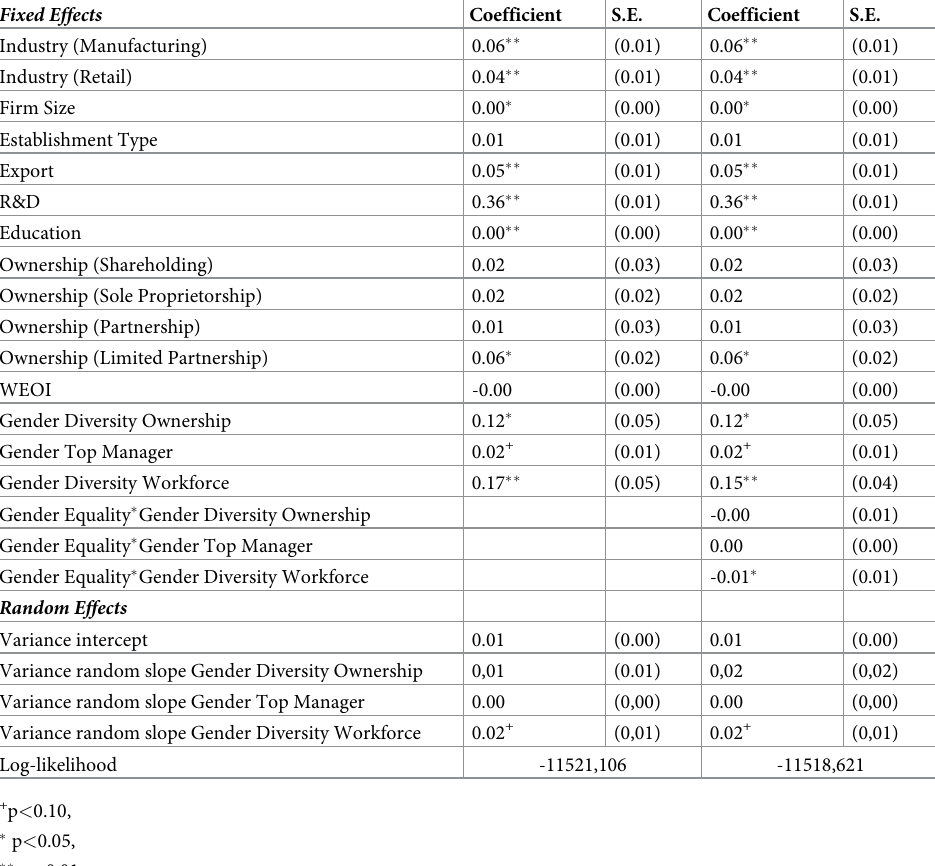
Table 4. Robustness test. Hierarchical linear model: effect of gender diversity and the interaction effect between gen- der diversity and gender equality on innovation (n = 18 547). Fixed